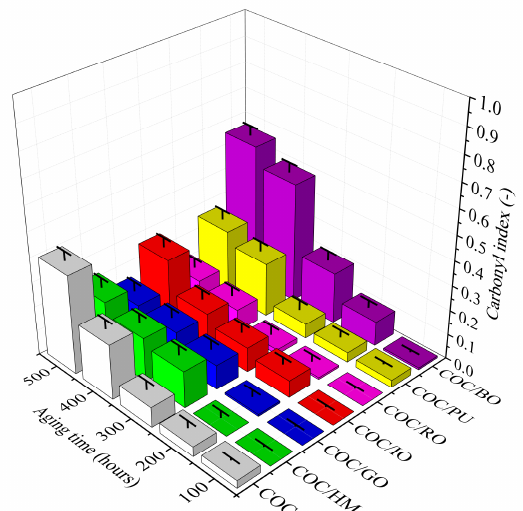
Figure 3. FTIR spectra of the COC copolymer composite ( a ) and COC/RO composite ( b ) before and after aging.